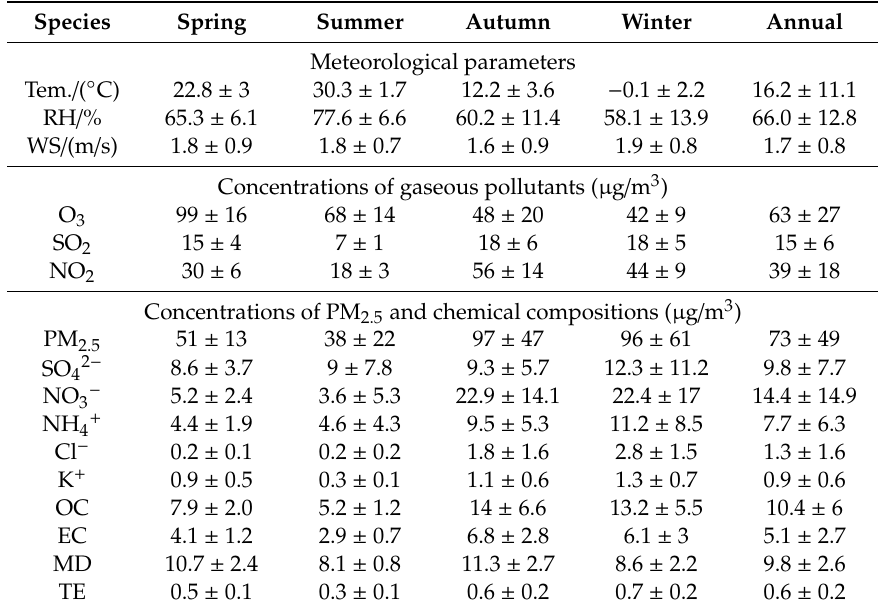
Table 1. Seasonal and annual average concentrations of PM 2.5 and of the major chemical species, as well as meteorological parameters and the concentrations of gaseous pollutants during the sampling period